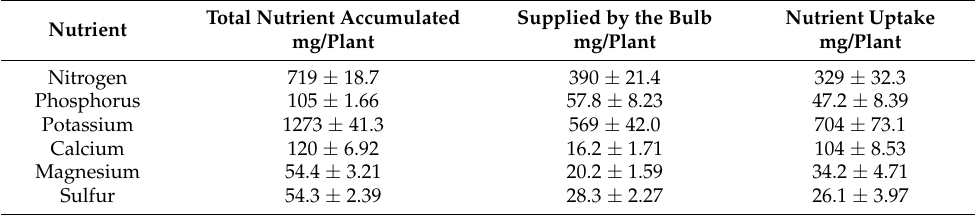
Table 1. Total macronutrients accumulated by lilium plants (mean ± standard error) at the end of the growing season and the amount provided by the bulb or absorbed from the growing medium.